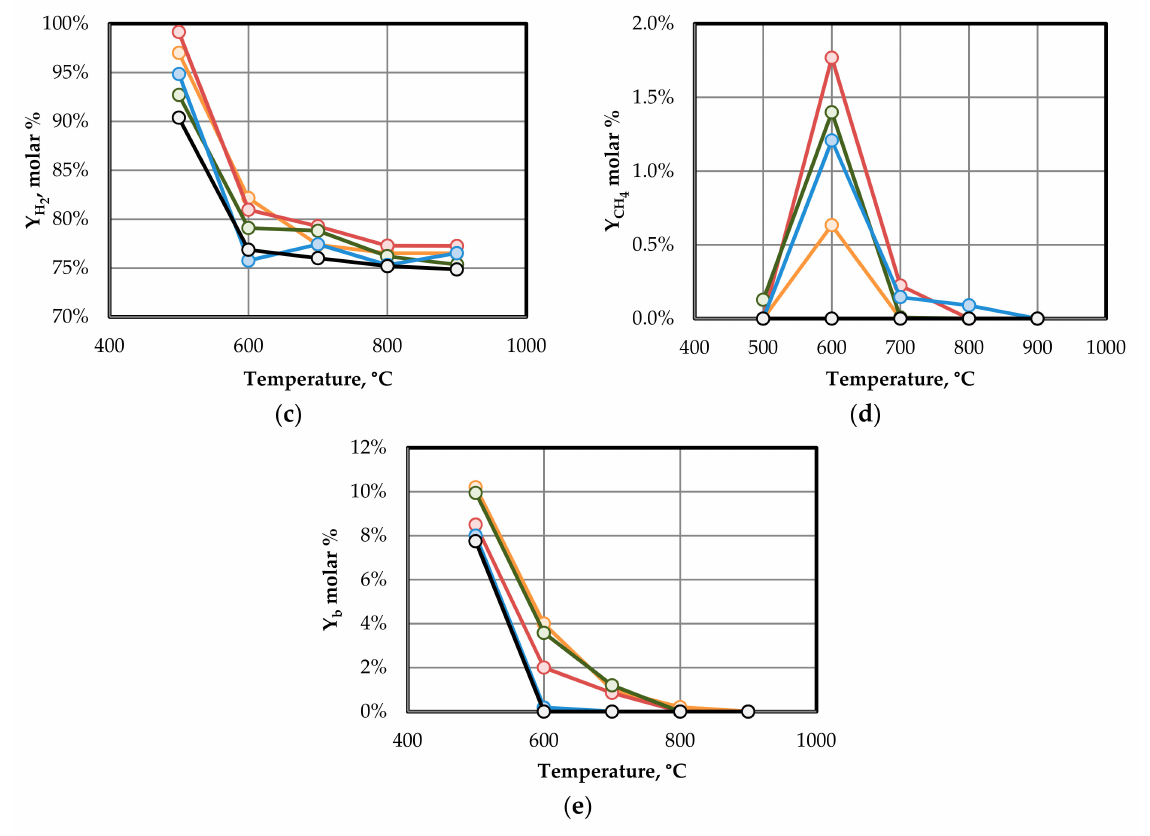
Figure 9. Molar gas composition as function of temperature and S/C ratio: ( a ) CO, ( b ) CO 2 , ( c ) H 2 , ( d ) CH 4 . ( e ) Benzene yield. S/C = 1 ( ), S/C = 2 ( ), S/C = 4( ), S/C = 6 ( ), S/C = 8 (